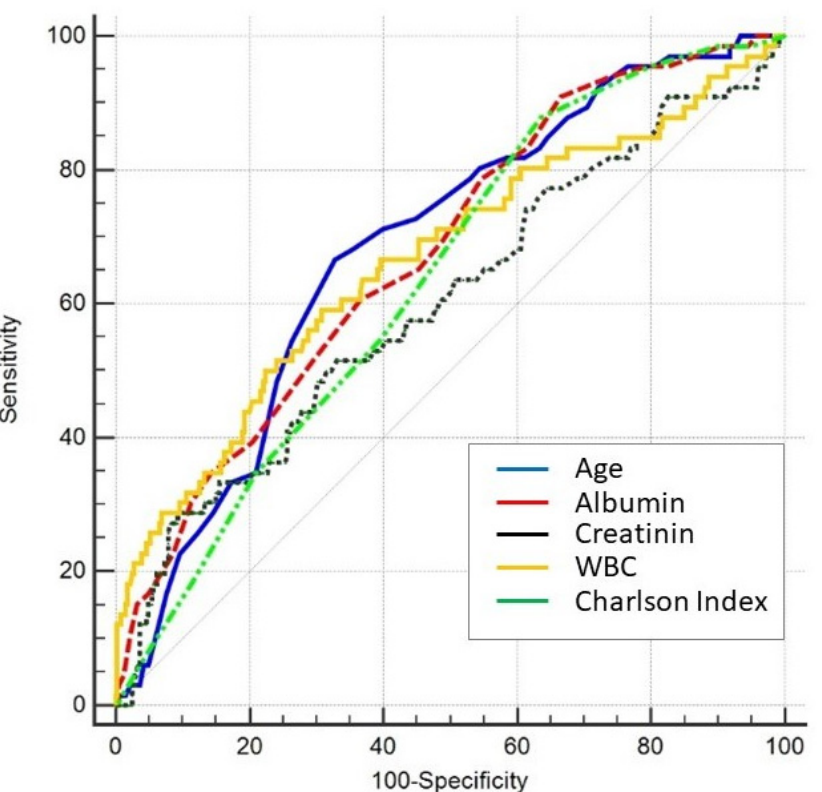
Figure 2. Receiver operating characteristic (ROC) analysis for age, creatinine, albumin, white blood cell count (WBC), and Charlson comorbidity index (CCI) at admission for all-cause in-hospital death. ROC areas under the curve: age, 0.684 (0.640–0.726); creatinine, 0.675 (0.631–0.717); WBC, 0.665 (0.620–0.707); albumin, 0.675 (0.631–0.717); and CCI 0.637 (0.592–0.681).